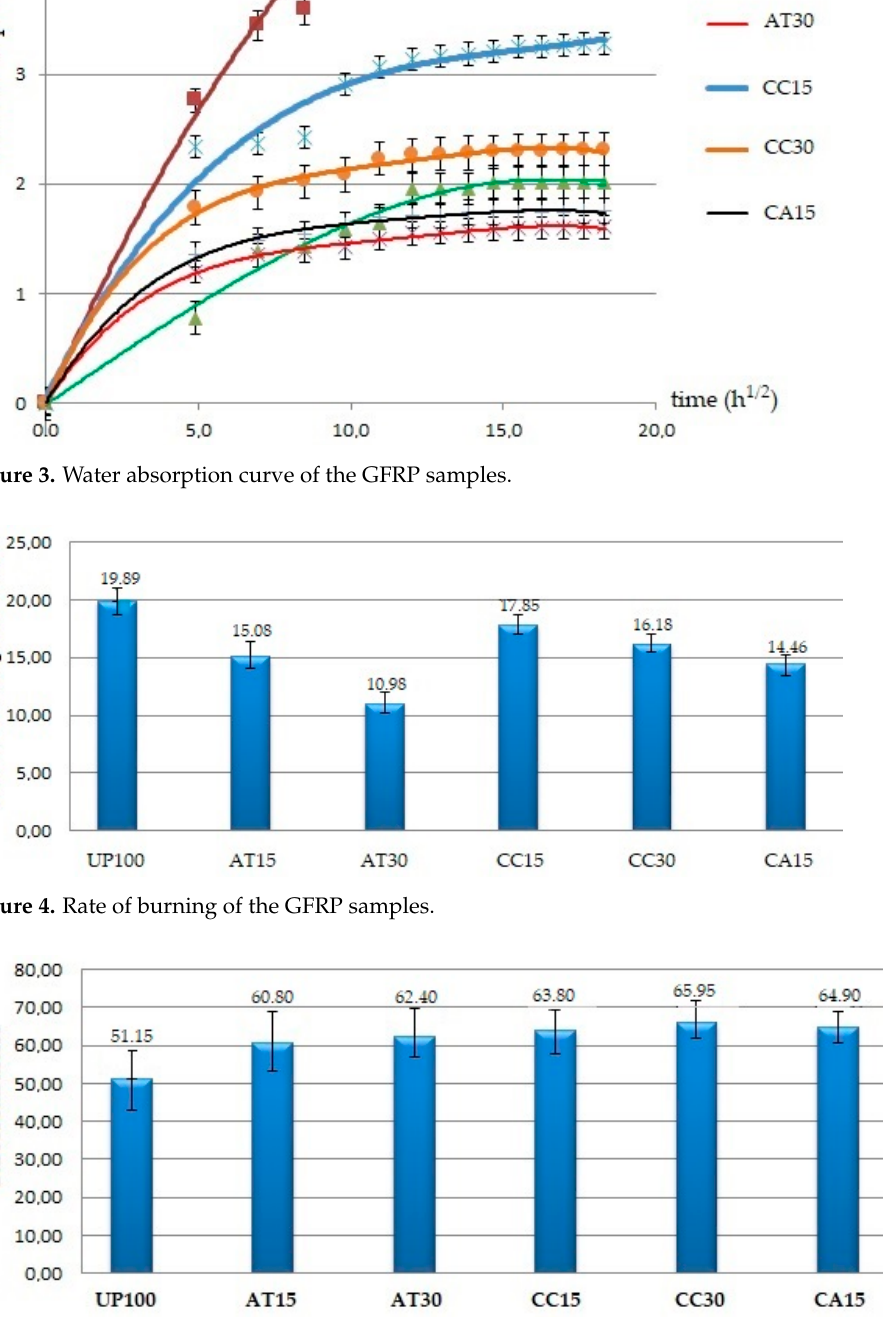
Figure 5. Barcol hardness of the GFRP samples.